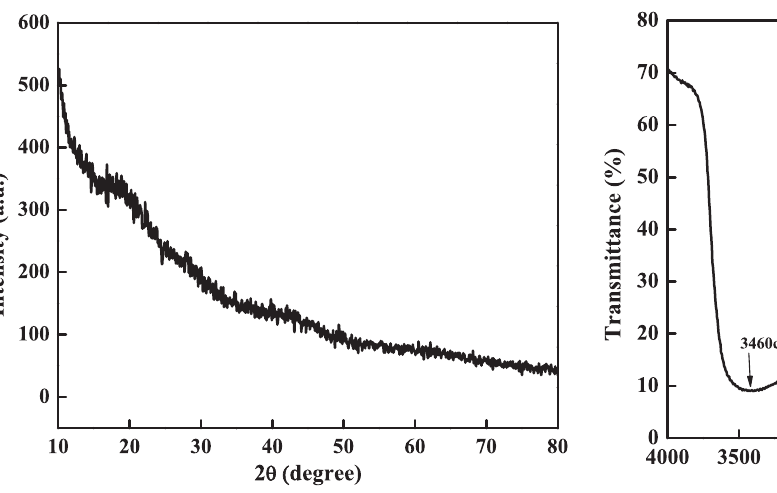
Fig. 2: XRD pattern of the aluminum compound powder obtained by reflux method, using aqueous solution, containing 7 × 10 − 3 mol/L aluminum nitrate, 3.5 × 10 − 3 mol/L potassium sulphate,